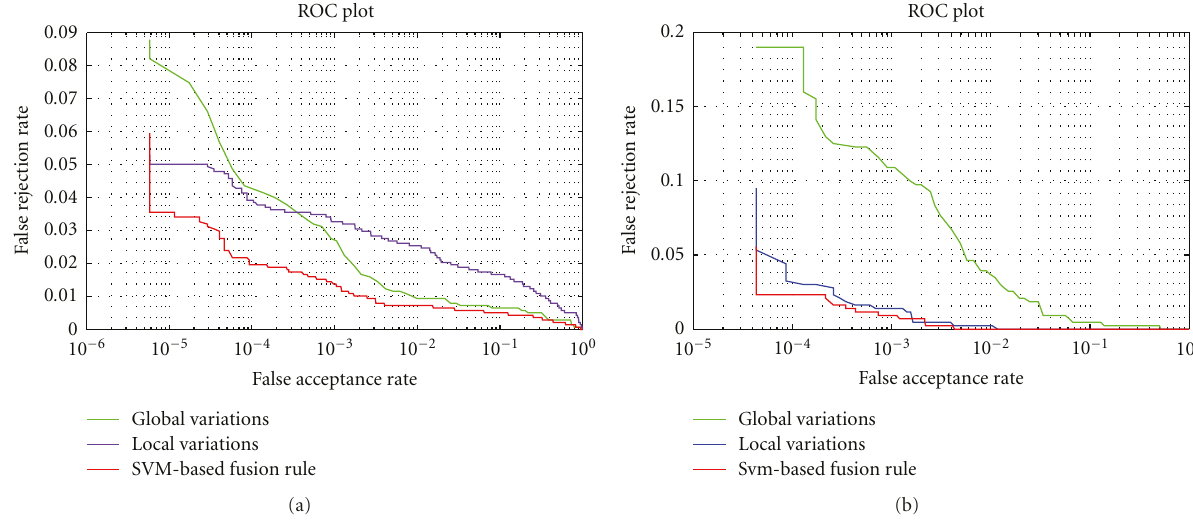
Figure 7: ROC plots of the local variations, the global variations, and the SVM-based fusion rule for (a) UBIRIS database (b) CASIA Version1 database. As it is seen, applying the fusion rule achieves a significant enhancement for both CASIA and UBIRIS databases. Note that the decimal values on the horizontal axis are not in the percentage format (i.e., 0.0001 stands for 0.01